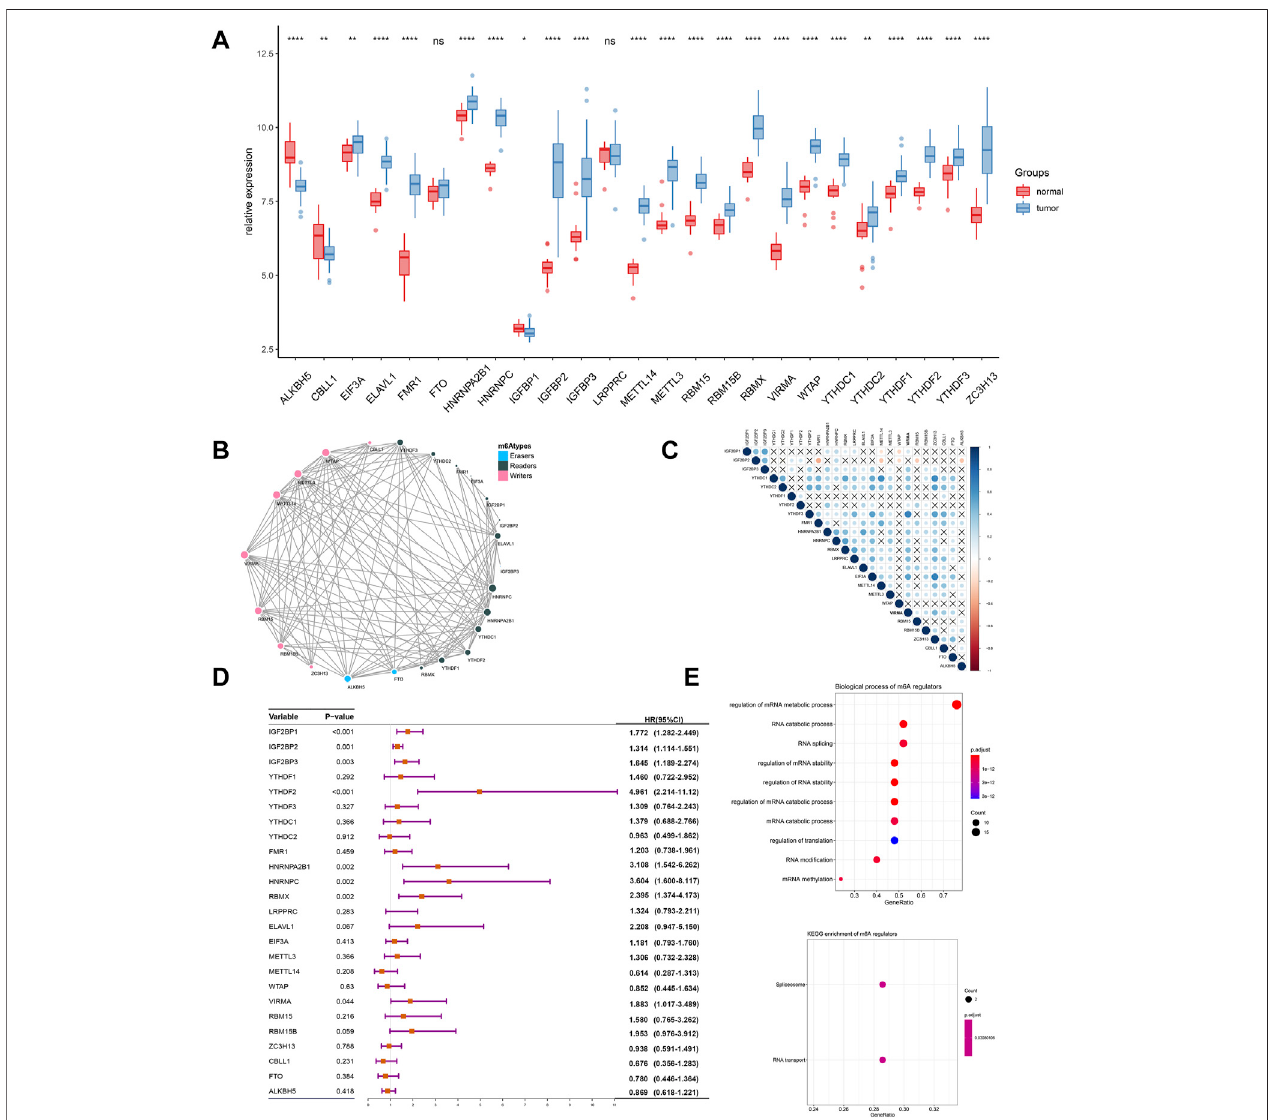
FIGURE 3 | Expression, interactions, prognosis, and functional annotations of 25 m6A regulators in STS. (A) Expression of different m6A regulators between normal samples and STS samples using the GSE17674 dataset; (B) PPI analysis of 25 m6A regulators; and (C) correlation plot among 25 regulators using Pearson correlation analysis. p < 0.010 indicated statistical signi fi cance. (D) Univariate Cox regression analysis for 25 m6A regulators in STS samples; (E) functional annotations for 25 m6A regulators. p < 0.05*, p < 0.01**, p < 0.001***, and p = 0****; ns, no signi fi